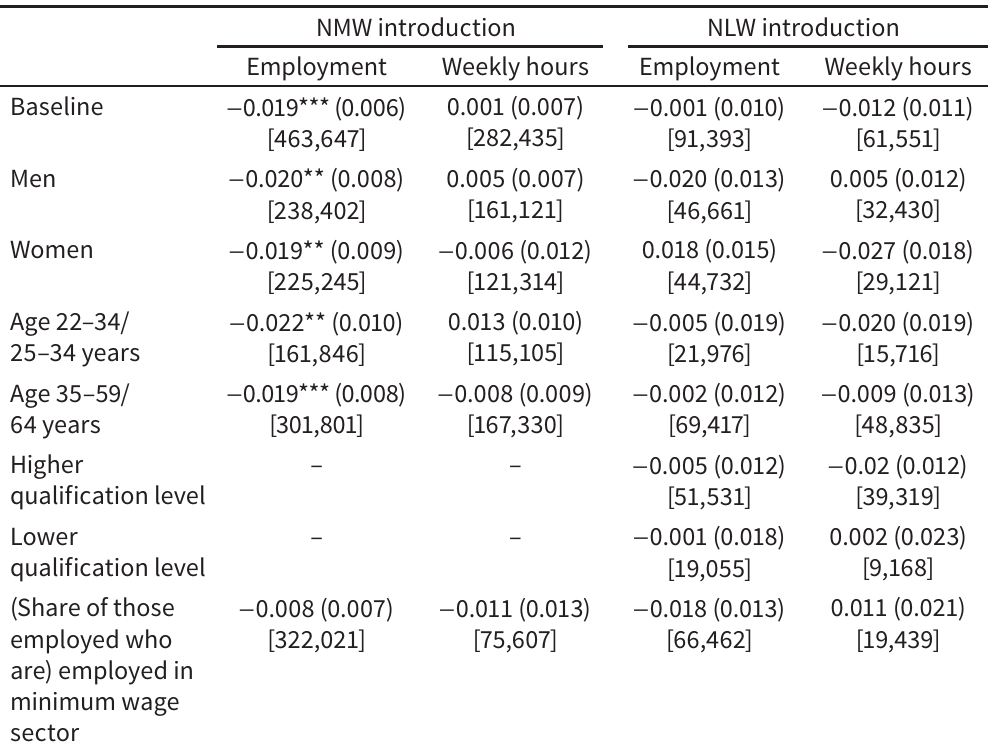
Difference-in-differences estimates of impacts of the NMW and NLW introduc- tions on employment and hours in NI, heterogeneous effects, constant treatment effects, coefficients (robust standard errors; number of